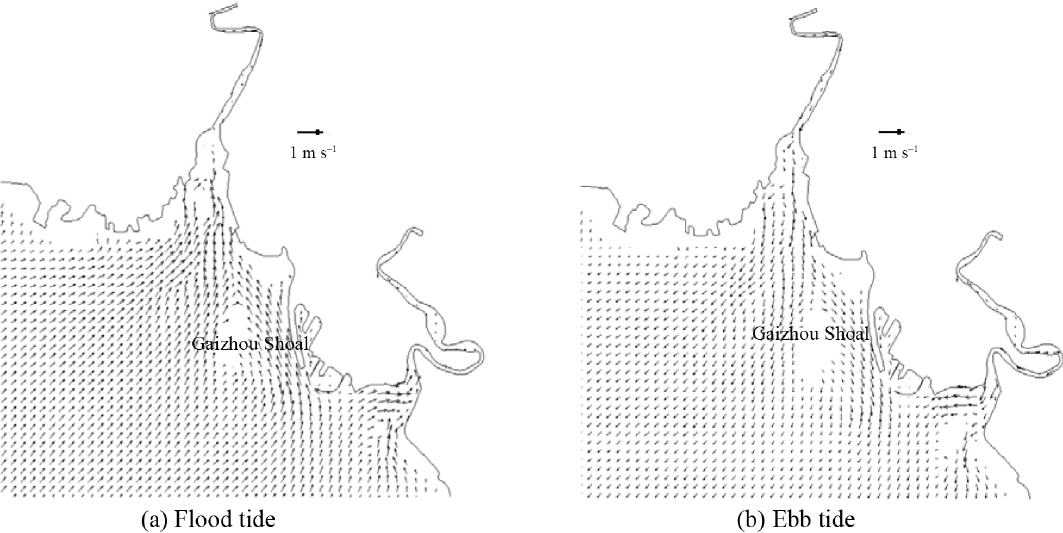
Figure 7. Flow field during neap tide, interpolated to a regular grid for clarity.